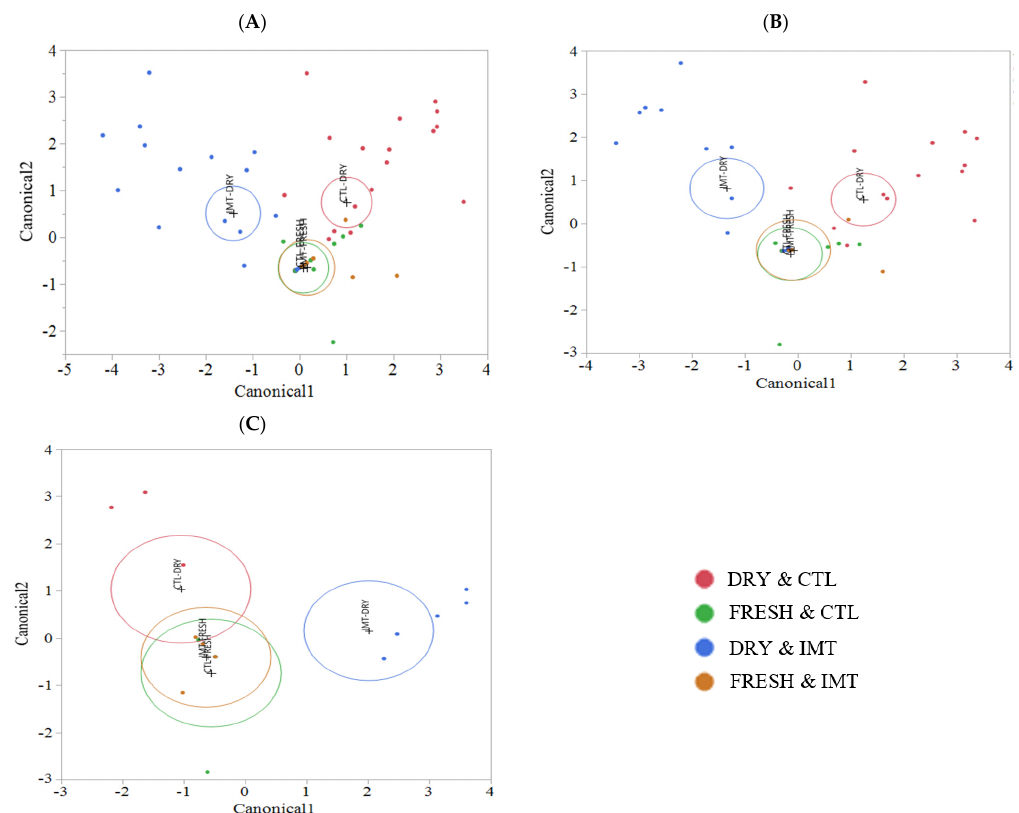
Figure 6. Discriminant analyses of milk sample microbiomes for each treatment group by sam- pling point for IMT cows treated with either: ( A ) cephapirin and cloxacillin ( B ) cephapirin only ( C ) cloxacillin only. Bacterial relative abundance was used as covariates, and treatment group as the categorical variable (NR = red dots, DR = blue dots). An ellipse indicates the 95% confidence region to contain the true mean of the group, and a plus symbol indicates the center (centroid) of each group. IMT: treatment group representing cows receiving intramammary antimicrobial drug treatment at dry − off; DRY: samples collected at the time of dry − off; FRESH samples: samples collected from post-partum cows between 4 and 11 days in milk; CTL: control group representing cows not receiving intramammary antimicrobial drug treatment at